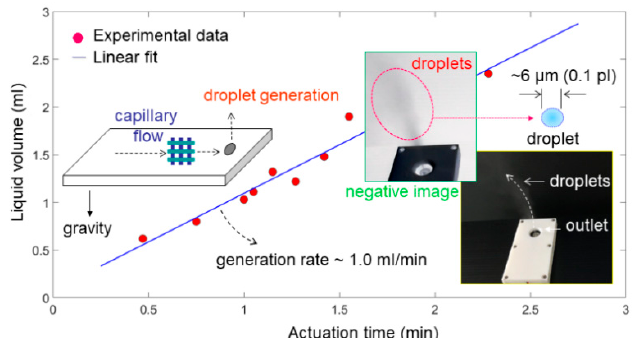
Figure 5. Liquid volume (mL) of water droplets generated during a period of actuation time (min), in which the generation rate was approximately 1.0 mL/min based on the linear fit (regression) of nine sets of experimental data.